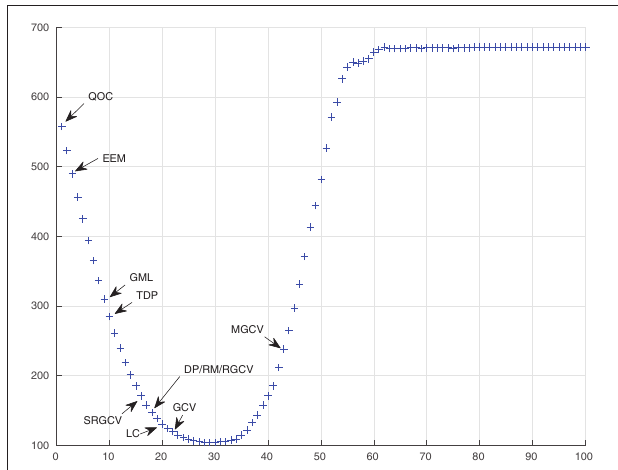
FIGURE 16 | The horizontal axis states the index k of the regularization parameter and the vertical axis shows